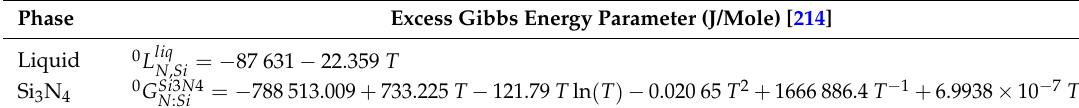
Table 14. The enthalpy and entropy of formation of the N-Si intermetallic compounds. Table 13. The enthalpy and entropy of formation of the N-Si intermetallic compounds.